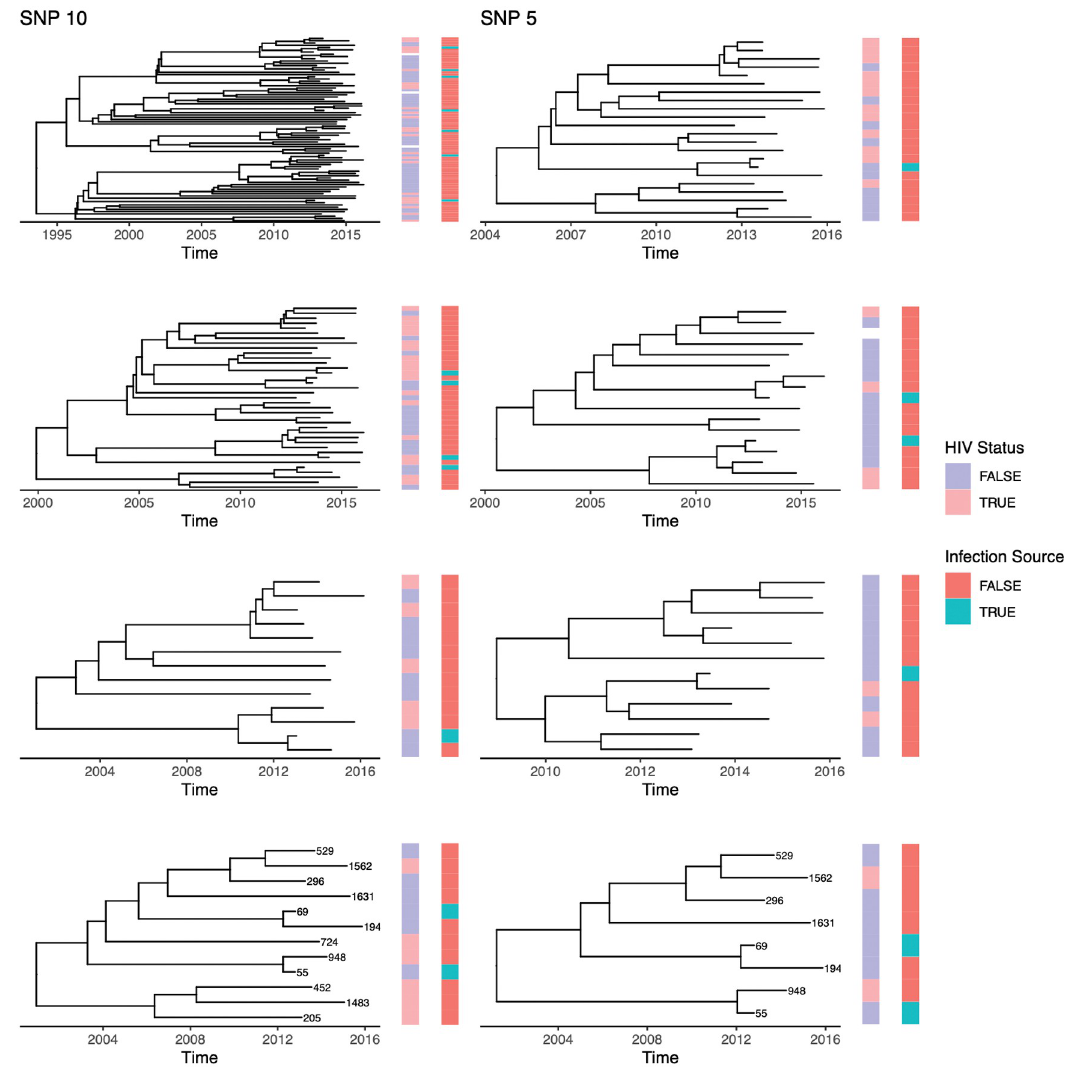
Fig 4. Timed phylogeny with tips labeled by HIV status and inferred infection source status using TransPhylo . Timed Phylogenies are generated in BEAST 2 . Before timed phylogenies are generated, TB genomes are first clustered by SNP distance based on a cutoff of either five or ten SNPs. The trees generated under each cutoff are different, but related to each other, with larger trees overall using a cutoff of ten SNPs as opposed to five. The plot was made using R package ggtree